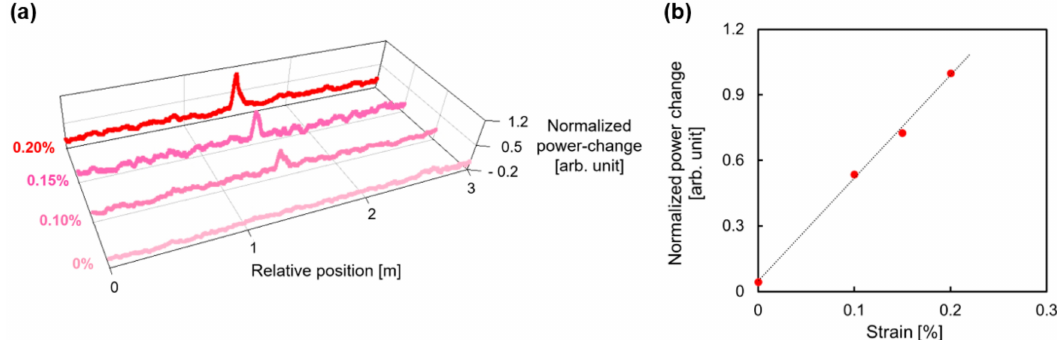
Figure 15. ( a ) Normalized power-change distributions along a silica SMF measured at four strains. ( b ) Maximal power-changes plotted as a function of strain. The dotted line is a linear fit. Reproduced with permission from [61]. Copyright (2016) JSAP.